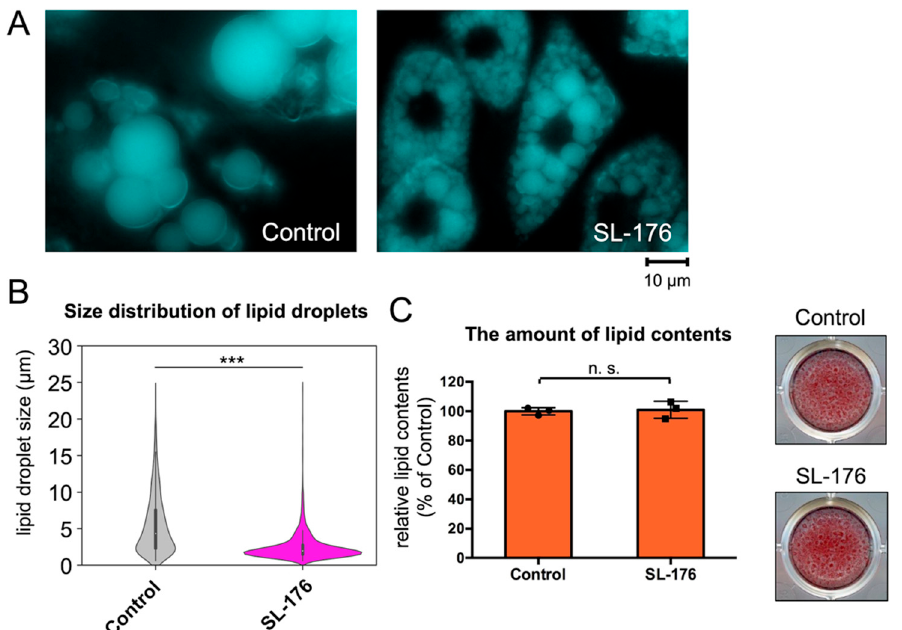
Figure 4. PPM1D-inhibition in mature 3T3-L1 adipocytes decreased the size of lipid droplet. ( A ) Lipid droplet imaging after inhibition of PPM1D. After differentiation for 8 days followed by treatment with SL-176 for 7 days, the cells were stained with monodansylpentane. ( B ) Violin plot of size distribution of lipid droplets of 3T3-L1 adipocytes. Data were obtained from three independent experiments of 3T3-L1 cells treated with DMSO vehicle (control) or 15 µ M of SL-176 for 7 days. Significance was analyzed